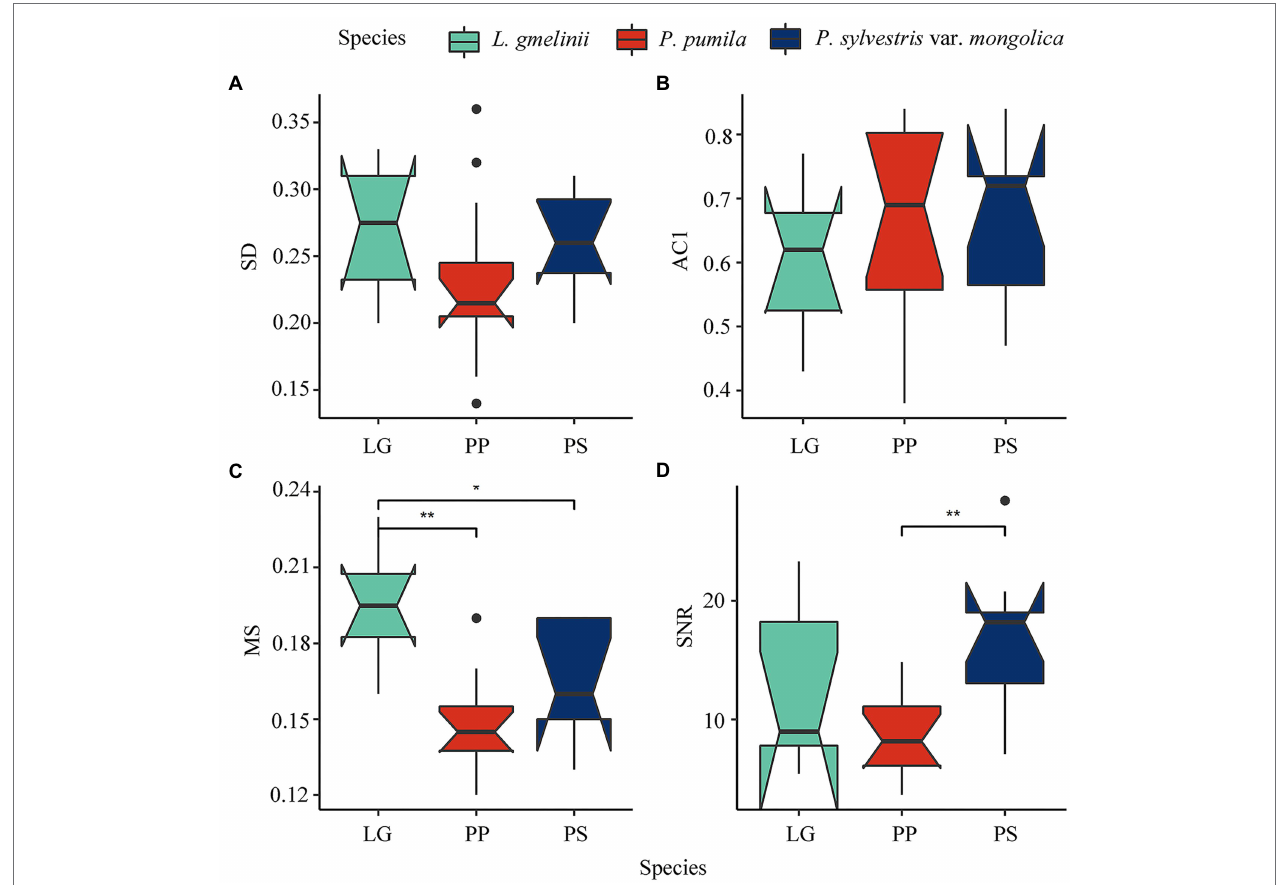
FIGURE 2 | Boxplot of three species chronology main statistics ( A : SD; B : ACI; C : MS; D : SNR) in this study, ** represent p < 0.01; * represent p < 0.01, those without * markings are not significant. SD, standard deviation; AC1, first order autocorrelation; MS, mean sensitivity; SNR, signal-to-noise ratio.